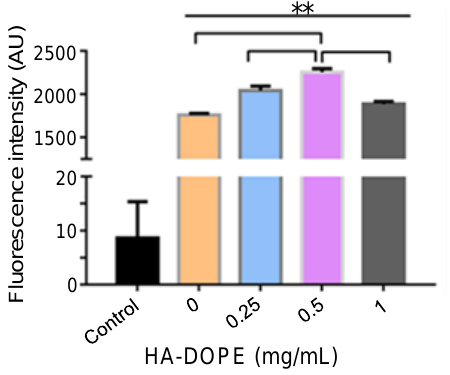
Figure 4. Mean fluorescence intensity of B16F10 cells following treatment with C6-HA-Lip with different HA-DOPE concentrations. (Comparison between groups, ** p < 0.01; n = 3).